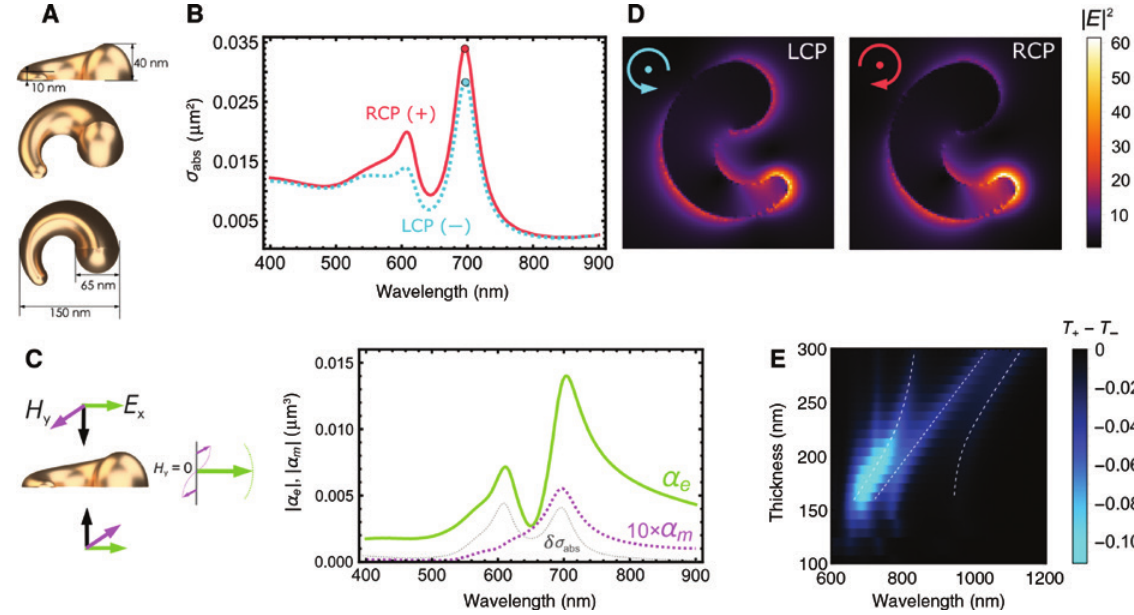
Figure 4: FDTD simulations of the chiral nanocrescent. (A) Side, tilted, and top views of the Au nanocrescent model used in FDTD simulations rendered with the use of 3D software. (B) Simulated absorption cross-section spectra of a single Au nanocrescent in vacuum illuminated by a right- and left-circularly polarized plane wave from top. (C) Multipole decomposition of a single Au nanocrescent in vacuum placed in an electric field anti-node of a standing wave with x –polarized electric field (see inset). Solid curves depict the x –components of induced electric and magnetic dipoles, converted to electric and magneto-electric polarizability units ( μ m 3 ) for convenient normalization; dashed curve shows the differential absorption cross-section RCP LCP . σ σ − (D) Simulated electric field intensity distributions excited by two circular polarizations in the horizontal plane at the base of abs abs a single Au nanocrescents in air. (E) Map of the simulated CD spectra of the coupled plasmon-cavity system versus the cavity thickness at normal incidence for a square nanocrescent array with 300 nm period placed in the middle of the PMMA-filled cavity. The dashed lines are guides for the